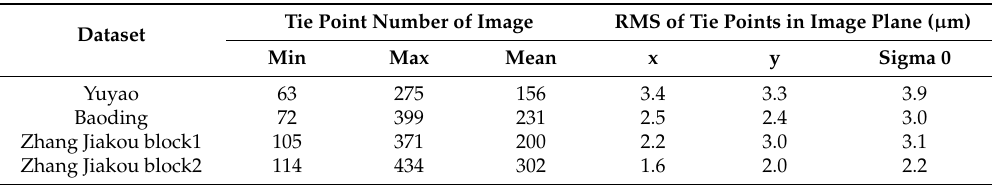
Table 5. Number and RMS statistics of the tie points.